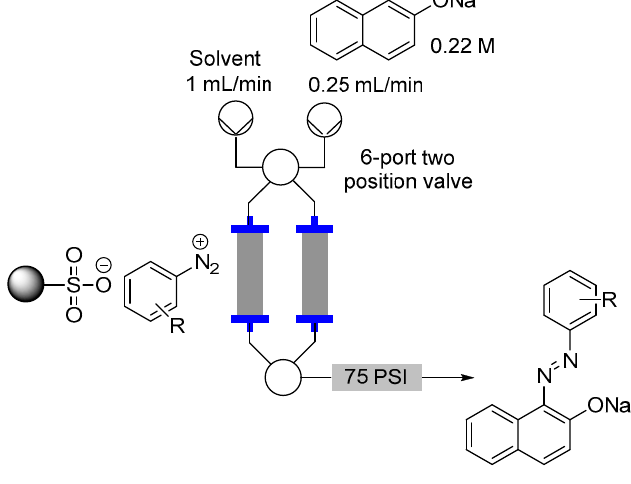
Figure 9. Flow reactor loading set-up.